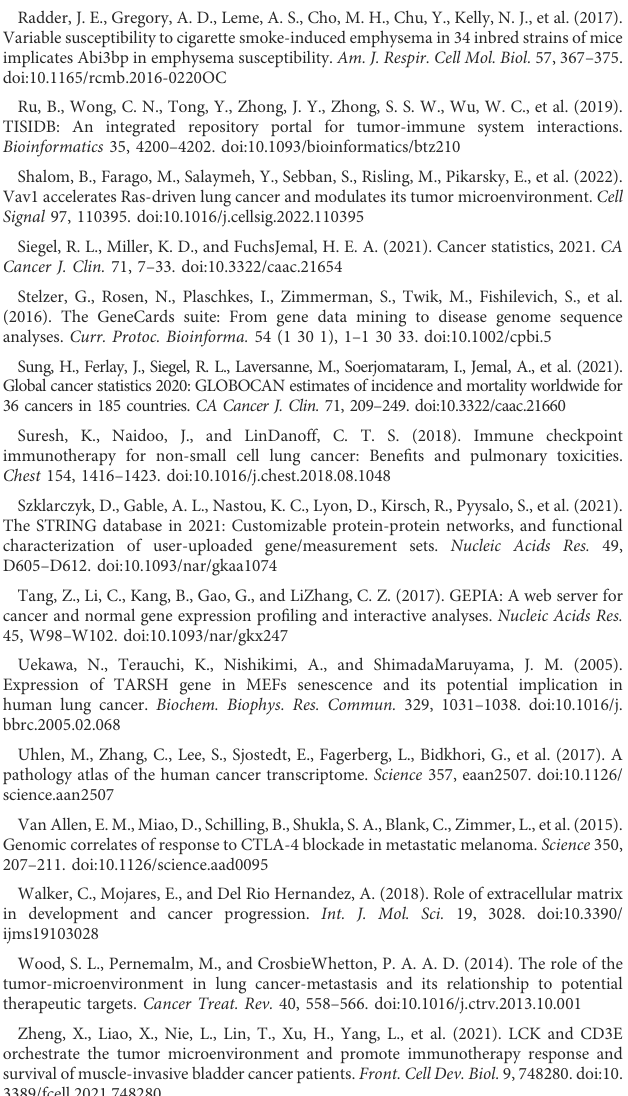
SUPPLEMENTARY FIGURE S1 Analysisofco-expressionnetworkofABI3BPgeneinLUSC. (A) Venndiagramof genesintersectionoftheExtracellularmatrixproteincodinggenesandABI3BP positively correlated genes. (B) Venn diagram of genes intersection of the Extracellular matrix protein coding genes and ABI3BP negatively correlated genes. The top 20 genes positively (C) and negatively (D) related with ABI3BP. (E) Identi fi cation of the hub genes. (F) GO & KEGG enrichment analysis of the hub genes in LUSC.